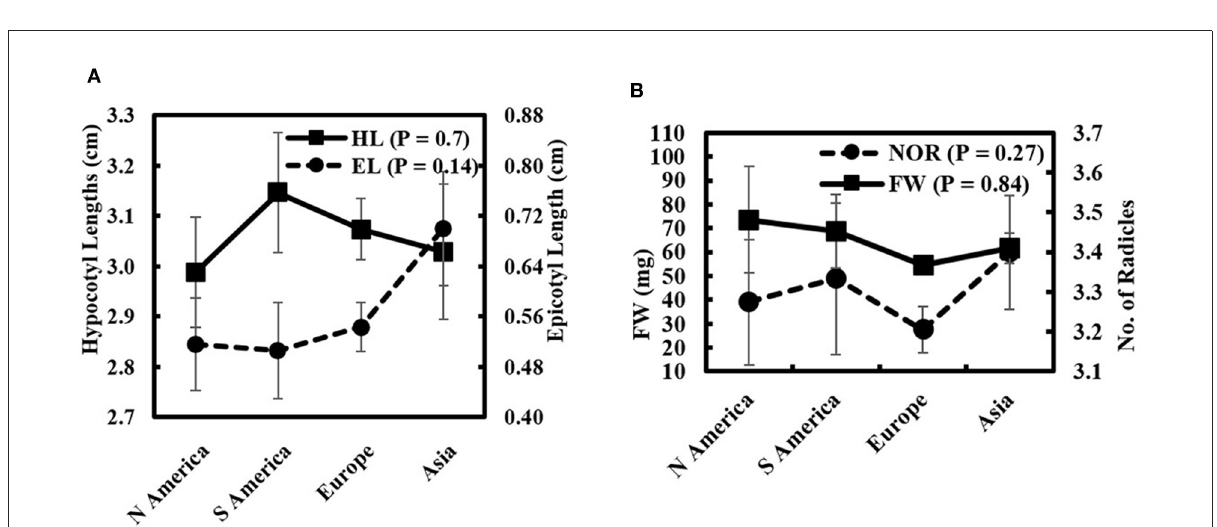
FIGURE4 Wheat genotypes attributes means classified according to their global affinities for (A) EL and HL and (B) FW and NOR under salinity stress (50% seawater).